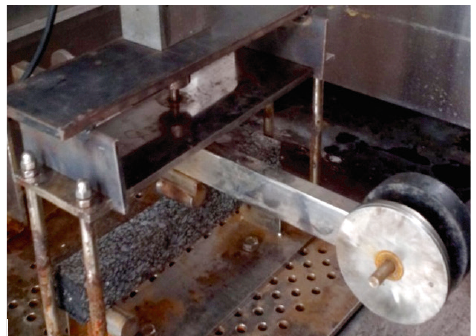
Figure 1. Bending creep test